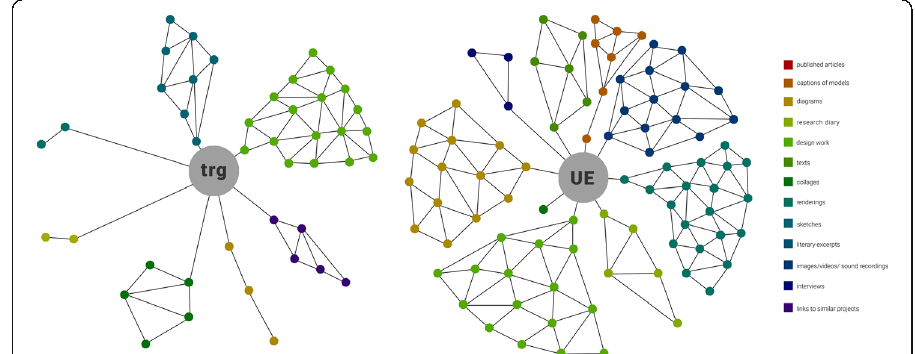
Fig. 3 Student Blog Activity: different colors correspond to different types of blog